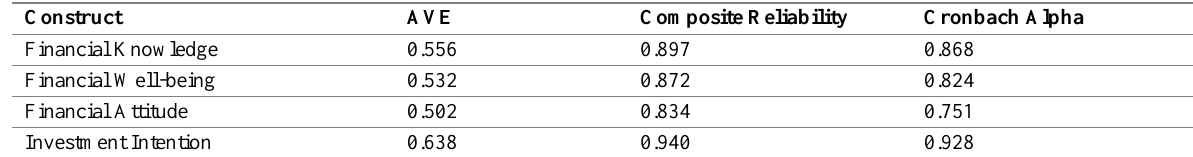
Table 2: AVE, Composite Reliability and Cronbach Alpha